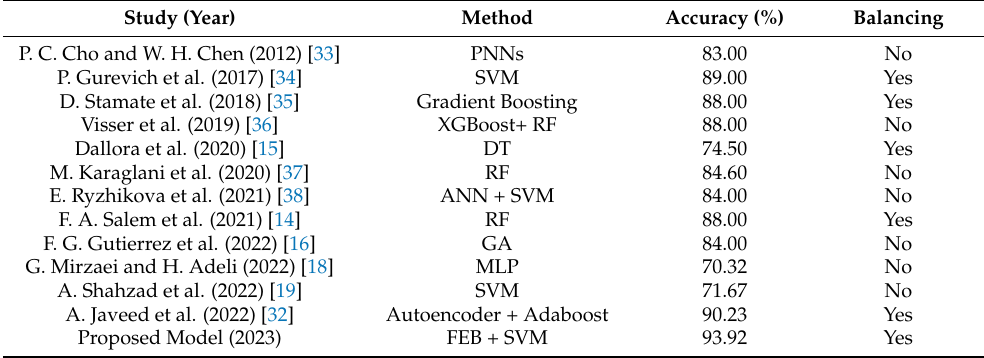
Table 6. Comparison of classification accuracies with previously proposed methods for dementia